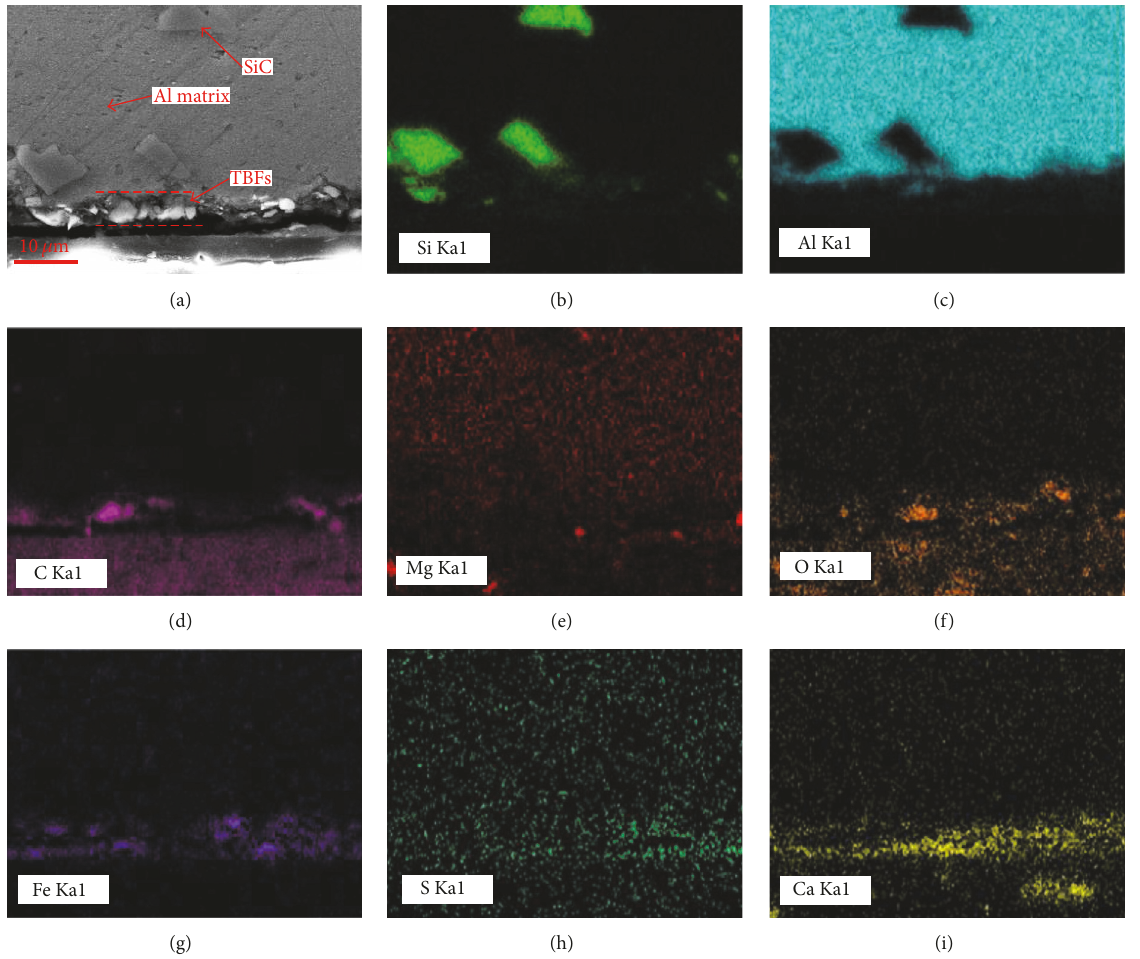
Figure 7: The subsurface topography and element distribution of composites specimen for the test of 30 ∘ C ∼ 100 ∘ C: (a) subsurface topography,